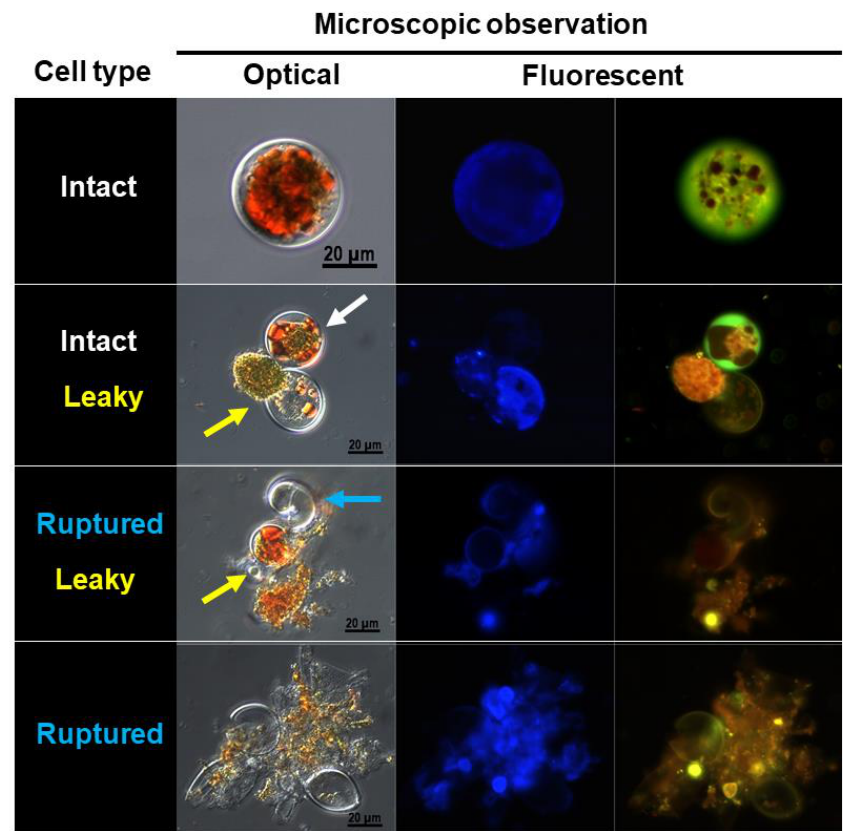
Figure 1. Microscopic images of H. pluvialis cysts after the high-pressure homogenization treatment (10,000 psi and one pass). Cell shapes were classified into three types (i.e., intact, leaky, and ruptured) considering their morphological changes by the mechanical breakages. See colored arrows for each cell type. From left to right, optical phase-contrast images; fluorescent images under DAPI filter showing the cell wall and other polysaccharides (blue stained with Calcofluor white); fluorescent images under fluorescein isothiocyanate solution (FITC) long-pass filter showing the proteins (green stained with FITC), lipids (yellow stained with Nile red), chlorophyll (red by auto-fluorescence), and astaxanthin (magenta by auto-fluorescence).